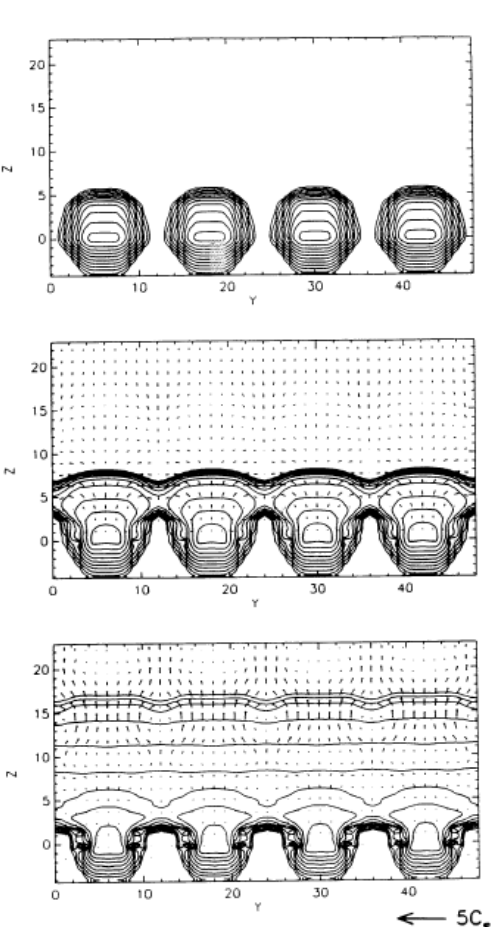
Figure 19: Surface of constant magnetic field strength from the result of 3D simulation of the rise of isolated flux tubes. Image reproduced with permission from Matsumoto et al. (1993), copyright by